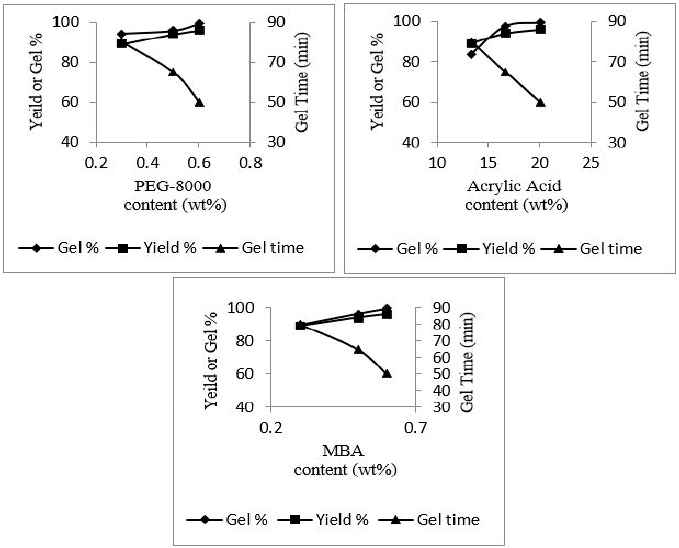
Figure 8. Yield %, gel %, and gel time of PEG-8000, AA, and MBA.